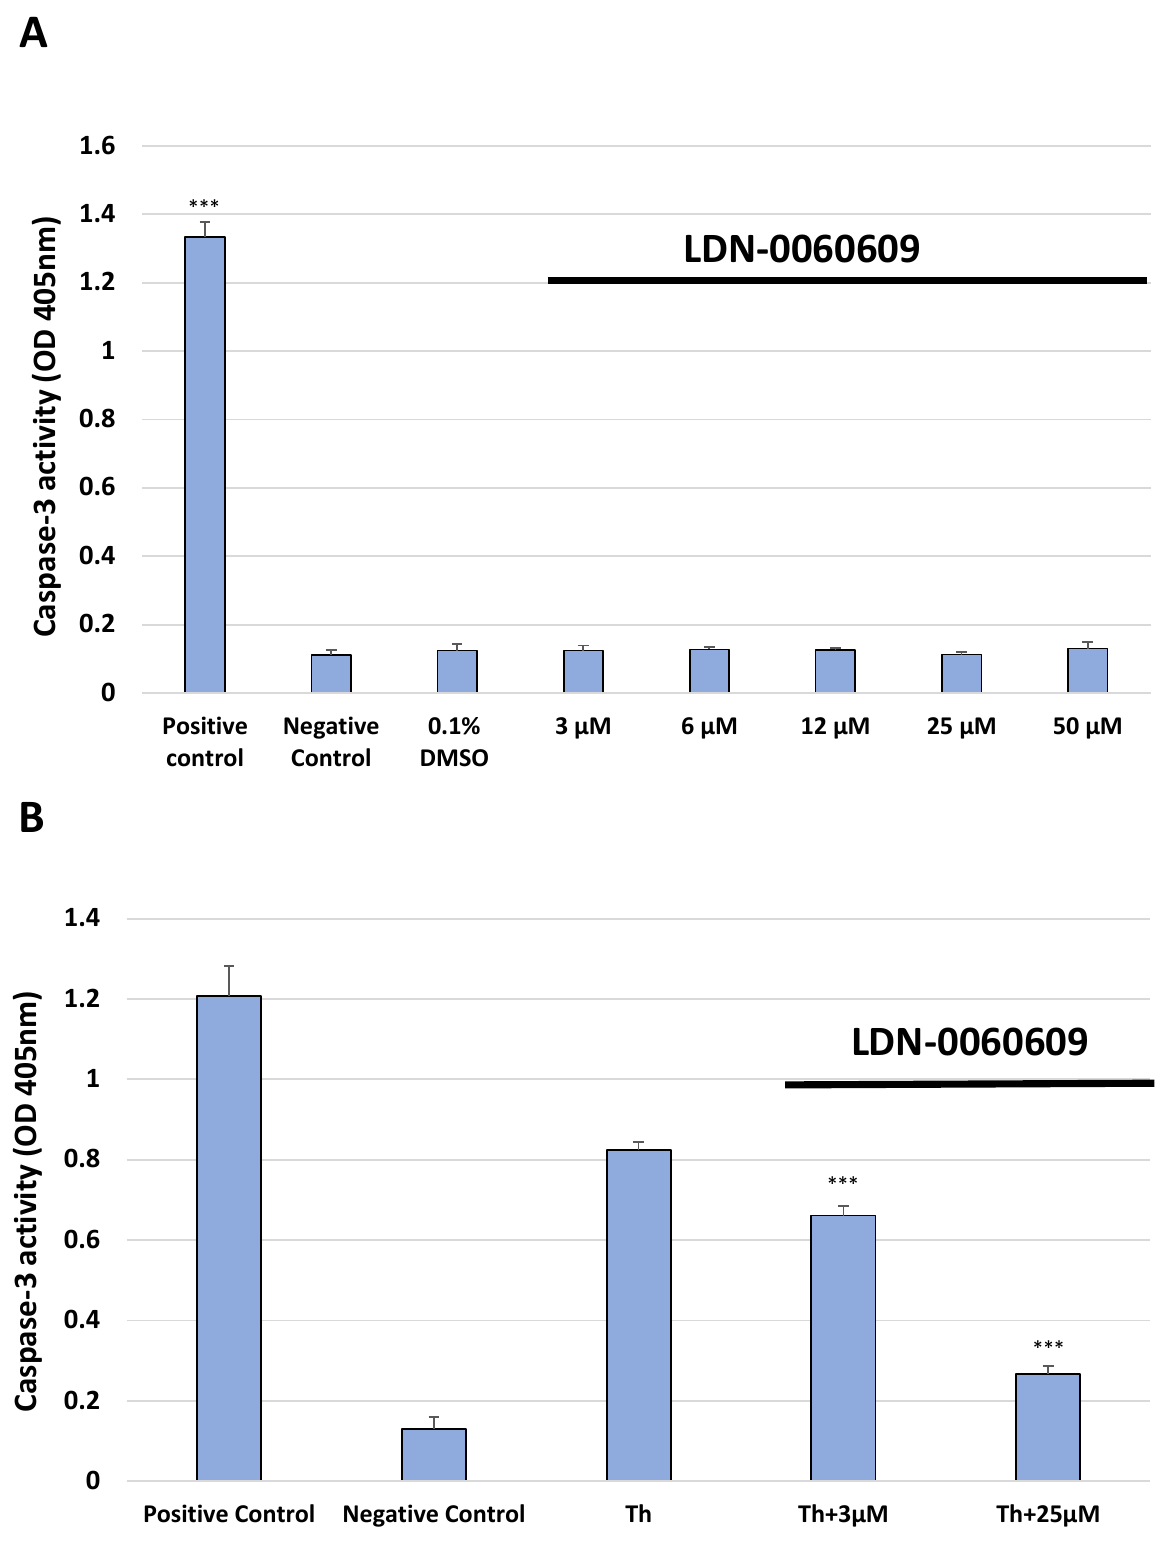
Figure 8. Analysis of apoptosis of the HTM cells treated with PERK inhibitor LDN-0060609 only ( A ) or with Th and PERK inhibitor LDN-0060609 ( B ) by the caspase-3 activity assay. Each of the statistical analyses in the individual experiments was based on the results of three independent tests. Data are expressed as mean ± SE ( n = 3). On the graphs, the differences were statistically significant as follows: *** p < 0.001 versus the negative control ( A ) and versus Th ( B ). DMSO—dimethyl sulfoxide;